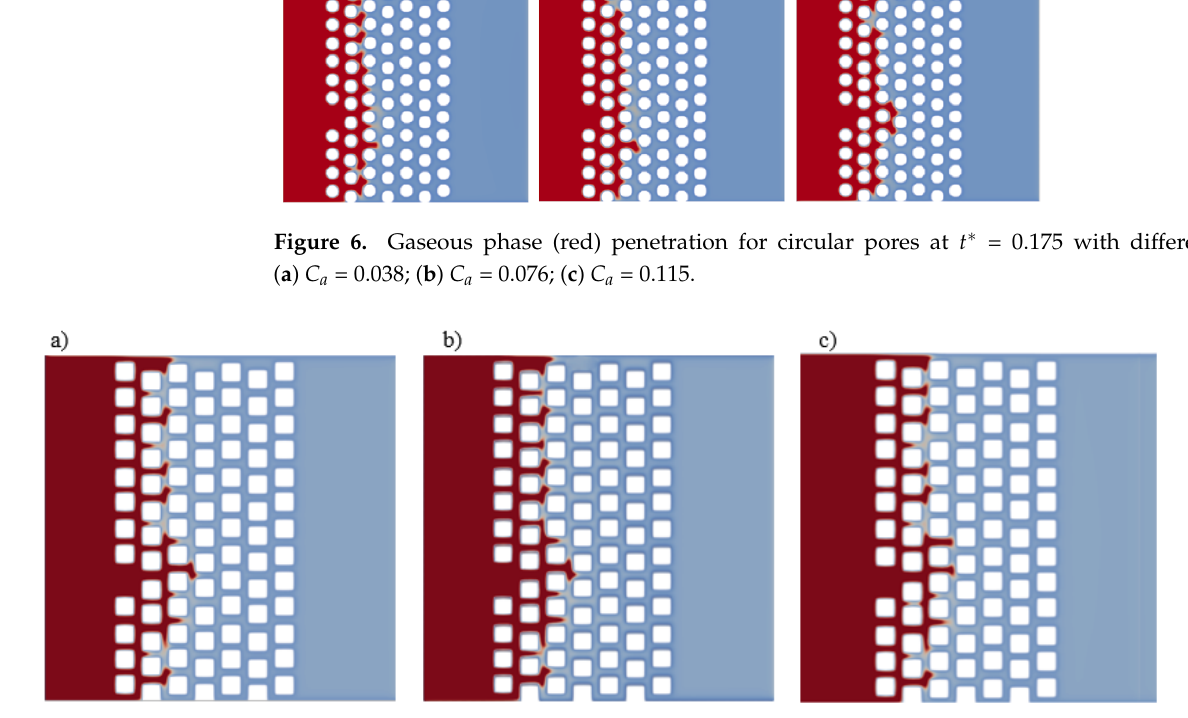
Figure 7. Gaseous phase (red) penetration for rectangular pores at t ∗ = 0.175 with different C a : ( a ) C a = 0.038; ( b ) C a = 0.076; ( c ) C a = 0.115.